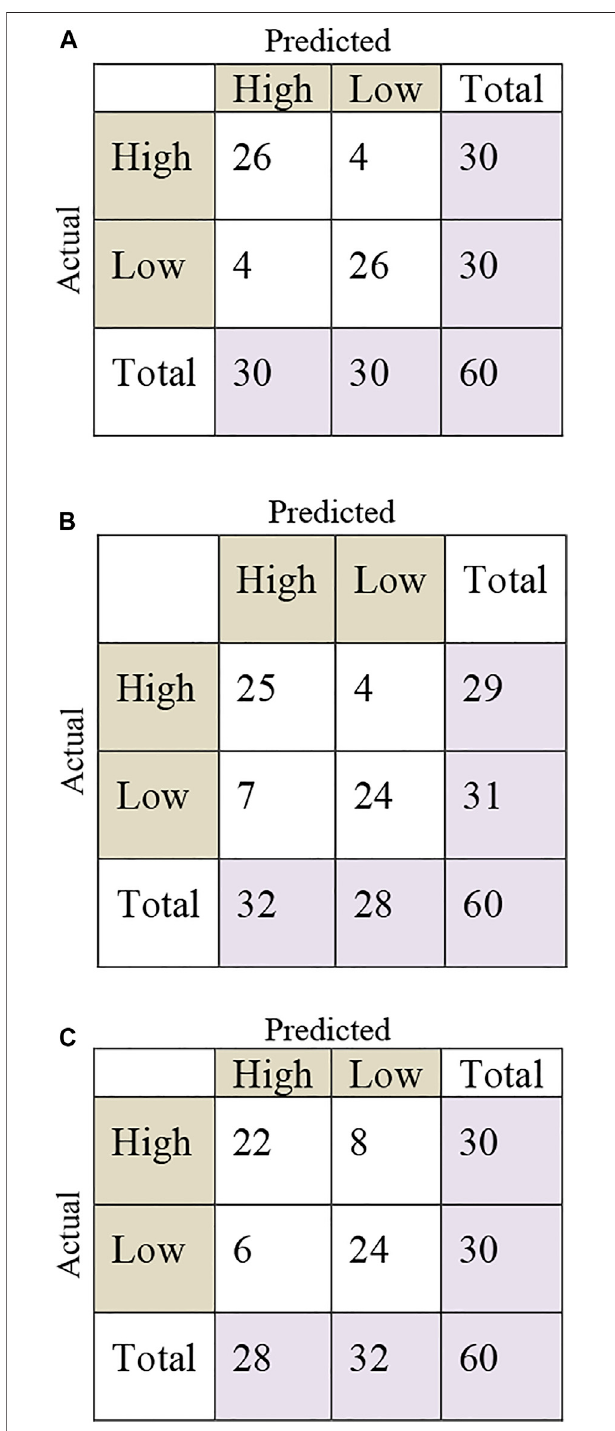
FIGURE 7 | (A) Confusion Matrix for SVM based upon 10 v-fold cross validation results; (B) Confusion Matrix for NB based upon 10 v-fold cross validation results; (C) Confusion Matrix for kNN based upon 10 v-fold cross validation results.